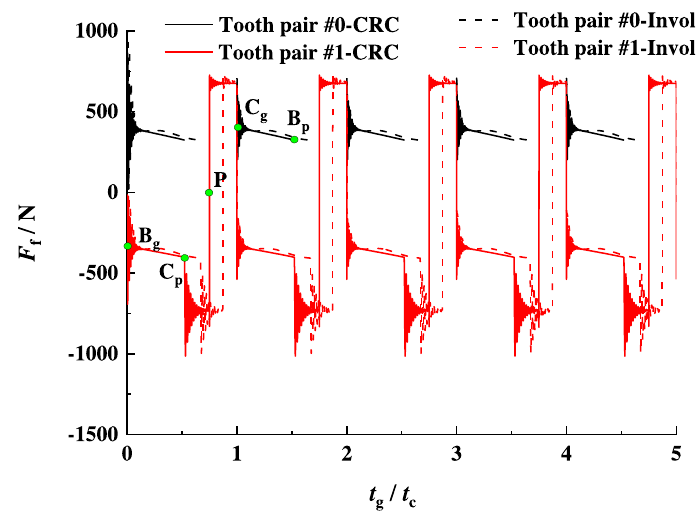
Fig. 12. Sliding friction forces.